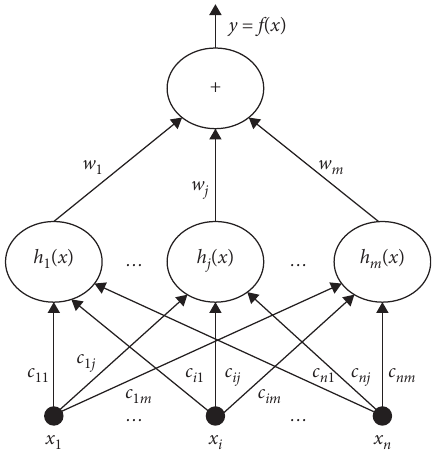
Figure 3: Radial basis neural network general